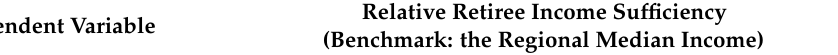
Table 10. Retiree relative income sufficiency decomposition in Australia and New Zealand (compared with the regional median